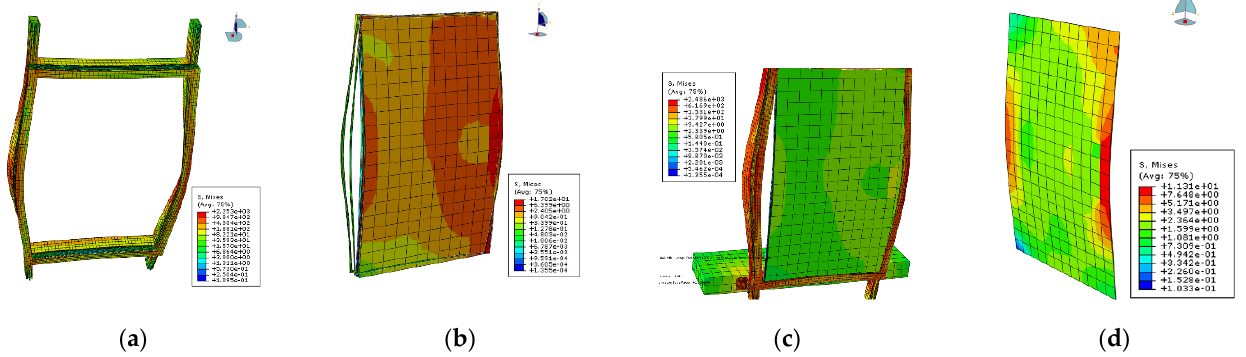
Figure 21. Stress distribution in each member of non-seismic curtain wall during Y -axis drift: ( a ) aluminum; ( b ) glass-to- gasket; ( c ) aluminum-to-glass; ( d ) glass.